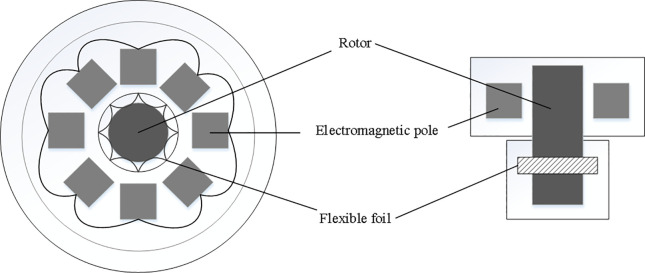
Structure of hybrid bearing.